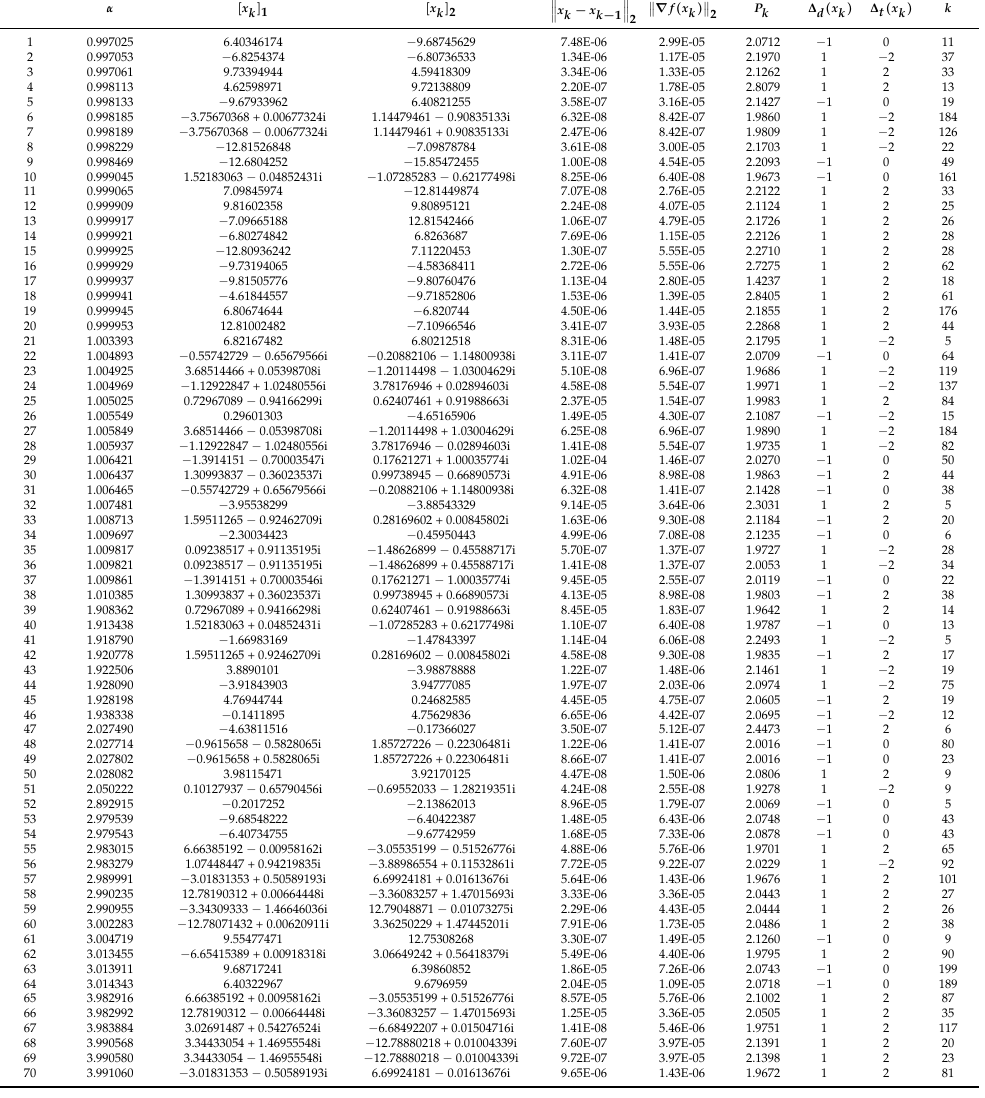
Table 3. Results obtained using the iteration function (74) with the fractional pseudo-Newton method